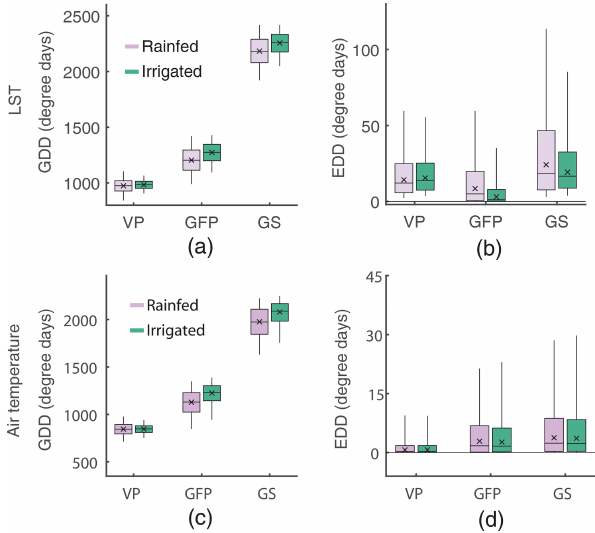
Figure 5. Box plot of GDD and EDD estimated with MODIS LST (a, b) and surface air temperature (c, d) for irrigated and rain- fed maize areas. Box plots indicate the mean (cross), median (hor- izontal line), 25th–75th percentile (box), and 5th–95th percentile (whiskers) of corresponding variables in all year and county combi-